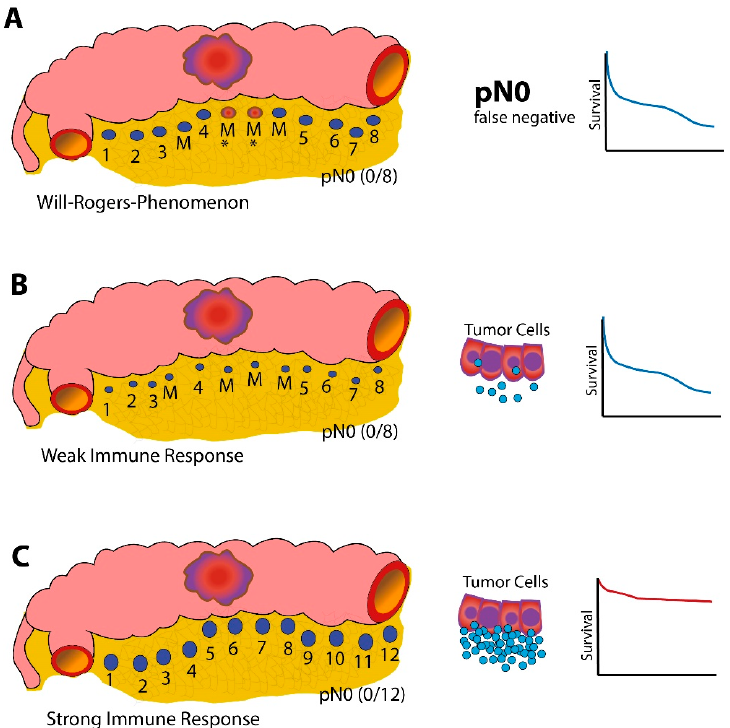
Figure 1. Hypotheses for the prognostic effect of the lymph node yield in colorectal cancer. ( A ) Stage migration effect (Will–Rogers Phenomenon). According to this thesis, the adverse prognostic effect of a low LN yield results from missing lymph node metastases due to insufficient dissection. ( B ) Al- ternative Thesis. Small hypoplastic lymph nodes are difficult to identify and lead to a low lymph node yield. A small lymph node size correlates with a low density of tumor-infiltrating lymphocytes (TILS) and indicates a weak immune response that enables the immune escape of tumors. ( C ) Large lymph nodes are easy to identify in high numbers and indicate a strong immune response. They are associated with a high density of TILs and a favorable prognosis. Numbers indicate detected local lymph nodes. M = missed lymph nodes, * metastasized LNs, and blue circles = tumor-infiltrating immune